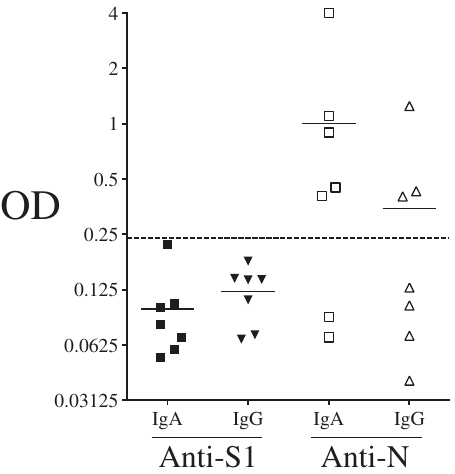
Fig. 5 Humoral responses in nonsurvivors and IgA and IgG response against S1 and N antigens. IgA (square) and IgG (triangle) response against the nucleocapsid (N, blank symbol), the spike (S1, fi lled symbol) protein. Each dot represents an individual. Dashed lines represent antibody speci fi city (responders).